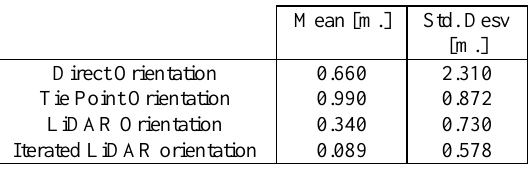
Table 3: 2008 Statical